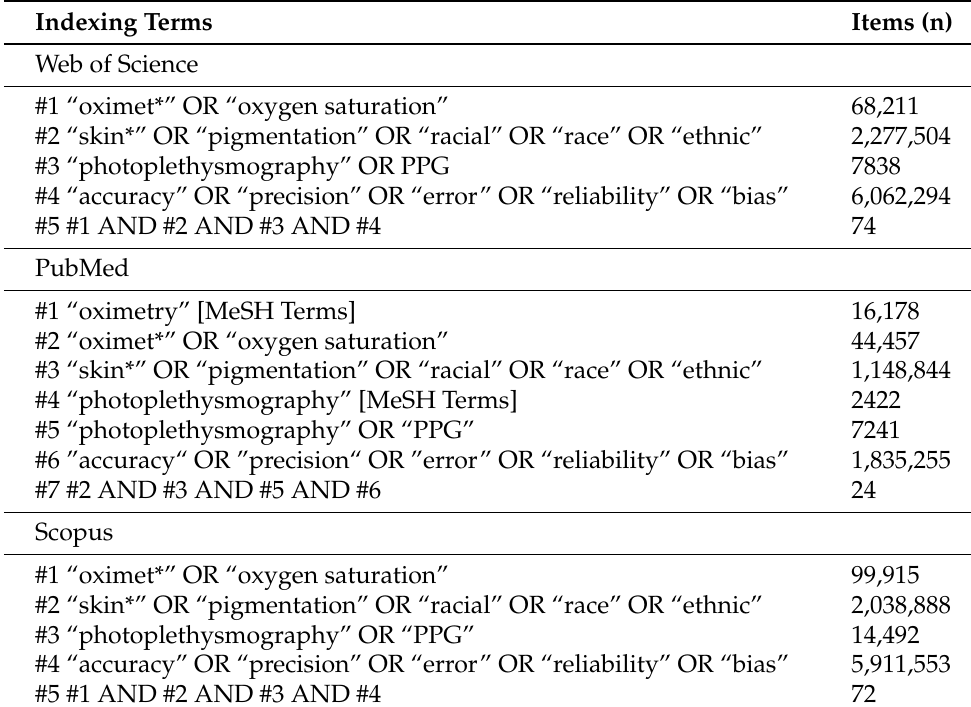
Table 1. Search strings, keywords and items per